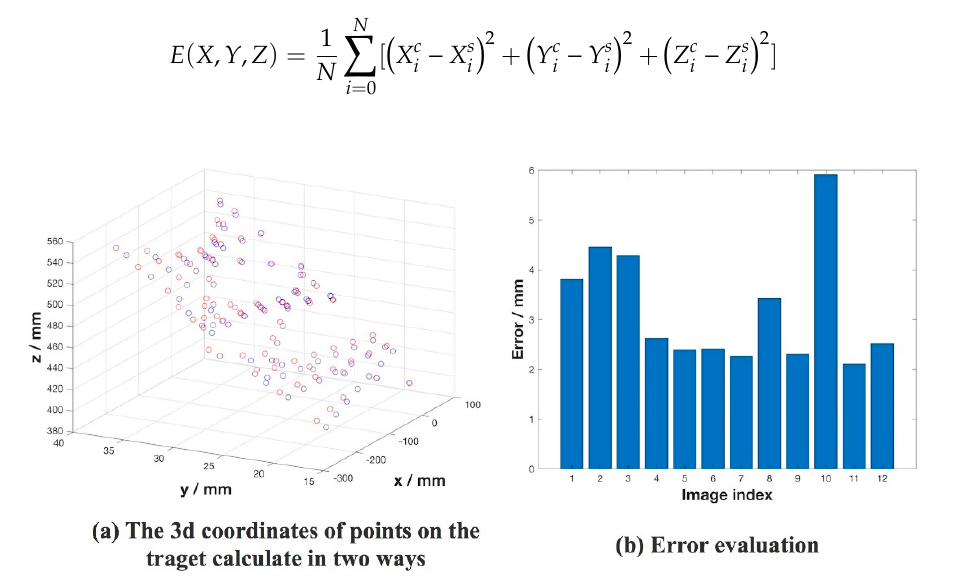
Figure 13. Measurement error evaluation of the sensor.